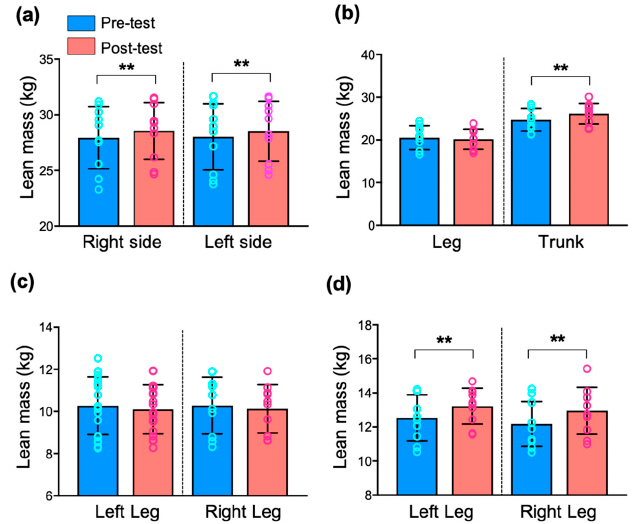
Figure 1. Change in regional lean mass following 8 weeks of Pilates training. ( a ) Lean mass in the right and left sides increased post-test ( p < 0.01). ( b ) Lean mass in the trunk, but not in the leg, increased post-test ( p < 0.01). ( c ) There was no significant change in lean mass in the right and left legs between pre- and post-test. ( d ) Trunk lean mass in the right and left sides increased post-test ( p < 0.01). All values are presented as mean ± SD (n = 11). Note: ** p < 0.01, vs. pre-test.